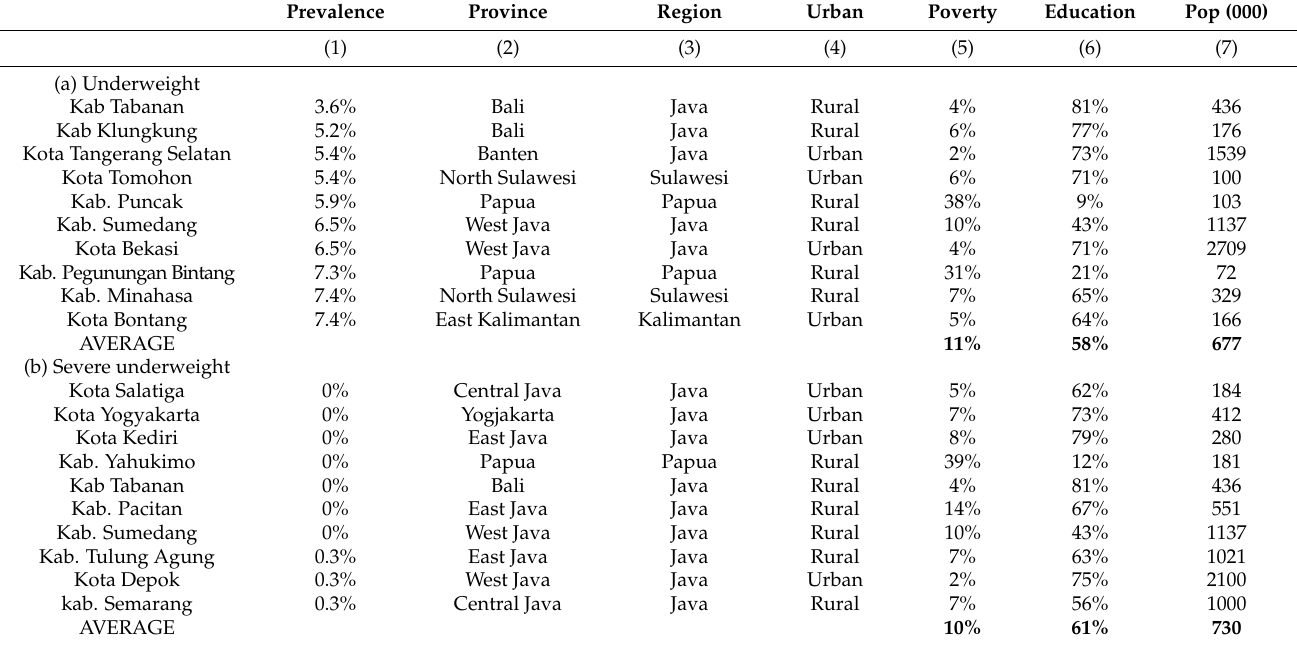
Table 3. Ten districts with the LOWEST prevalence of child undernutrition in Indonesia.